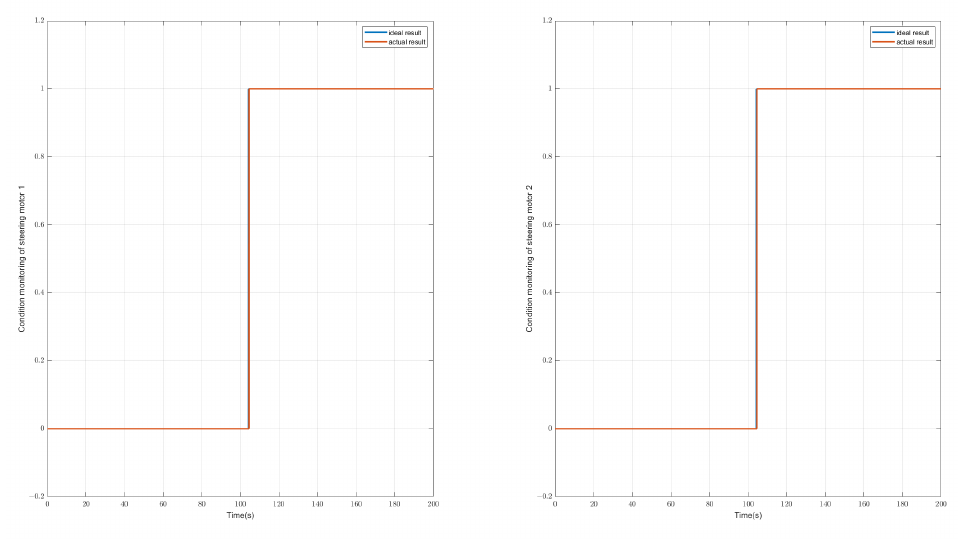
Figure 14. Diagnostic result of condition monitoring of the steering motors, this case shows that the steering motor 1 and steering motor 2 fail at 104 s. (Left: results for motor 1; Right: result for motor 2; Blue line: real state of the steering motor; Red line: diagnostic state of the steering